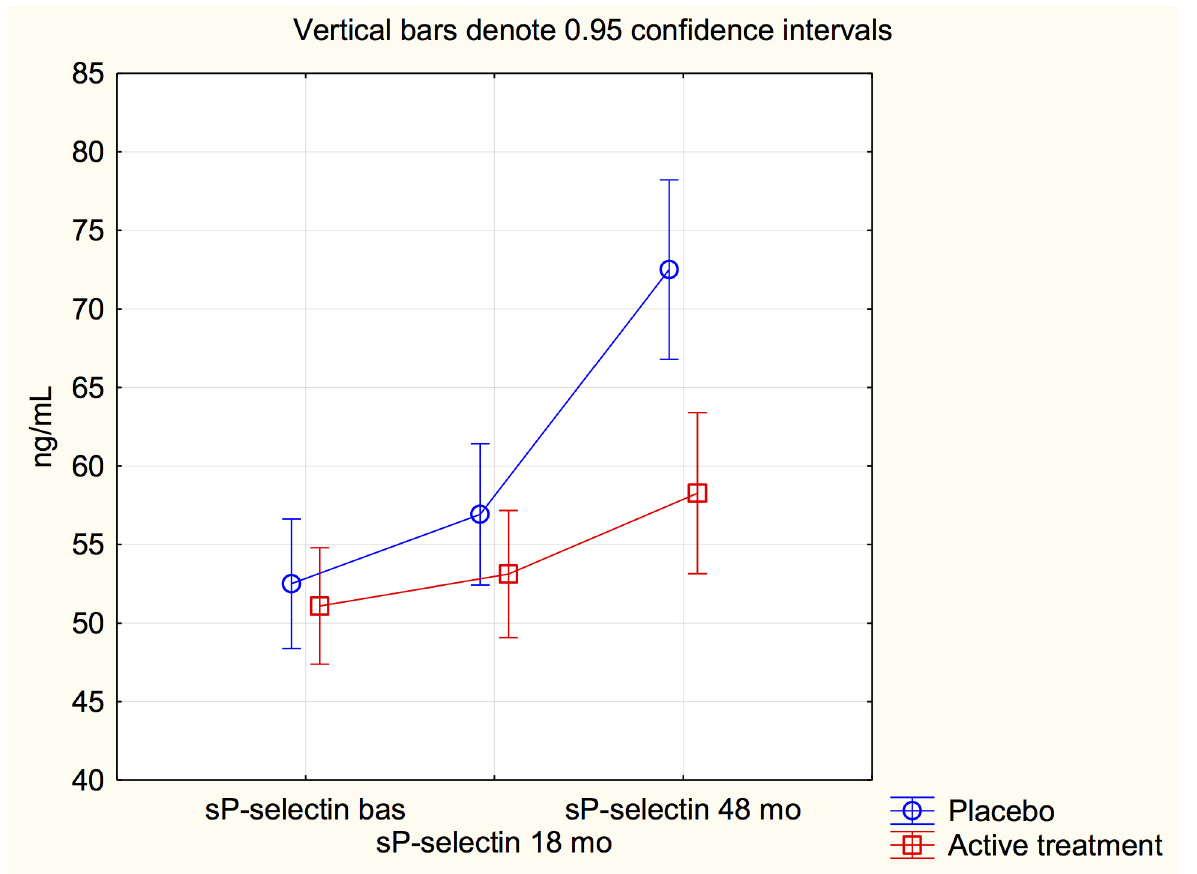
Fig 3. Graph illustrating sP-selectin measurements at study start, after 18 months and at study stop at 48 months in the study population given selenium and coenzyme Q10 combined, or placebo. Note: Analysis according repeated measures of variance.